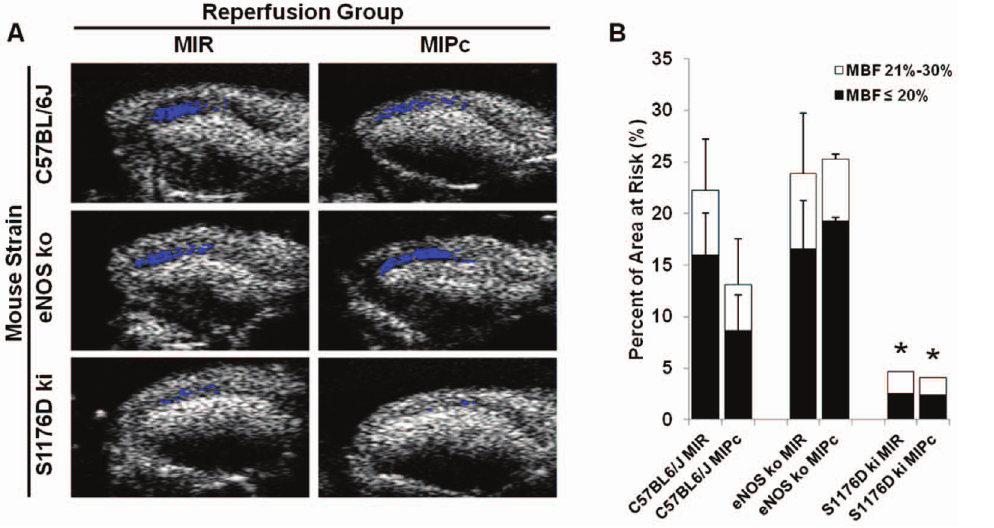
Figure 5. Effect of postconditioning and S1176D mutation on no-reflow zones. A. Representative images 30 minutes after reperfusion. Superimposed areas (blue) indicate regions with # 20% residual blood flow. B. Composite graph showing areas of the myocardium with # 20% (black) and # 30% (white) residual blood flow compared to preischemic baseline. MBF: myocardial blood flow. n=5–6 per group. Data are expressed as the mean 6 SD. *P , 0.05.